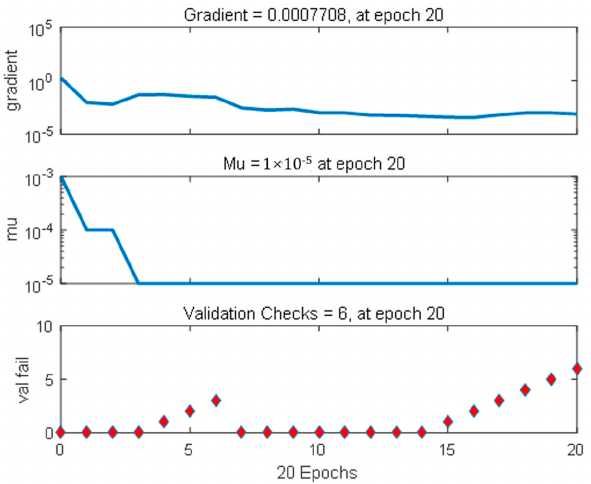
Figure 23. BPNN training status.